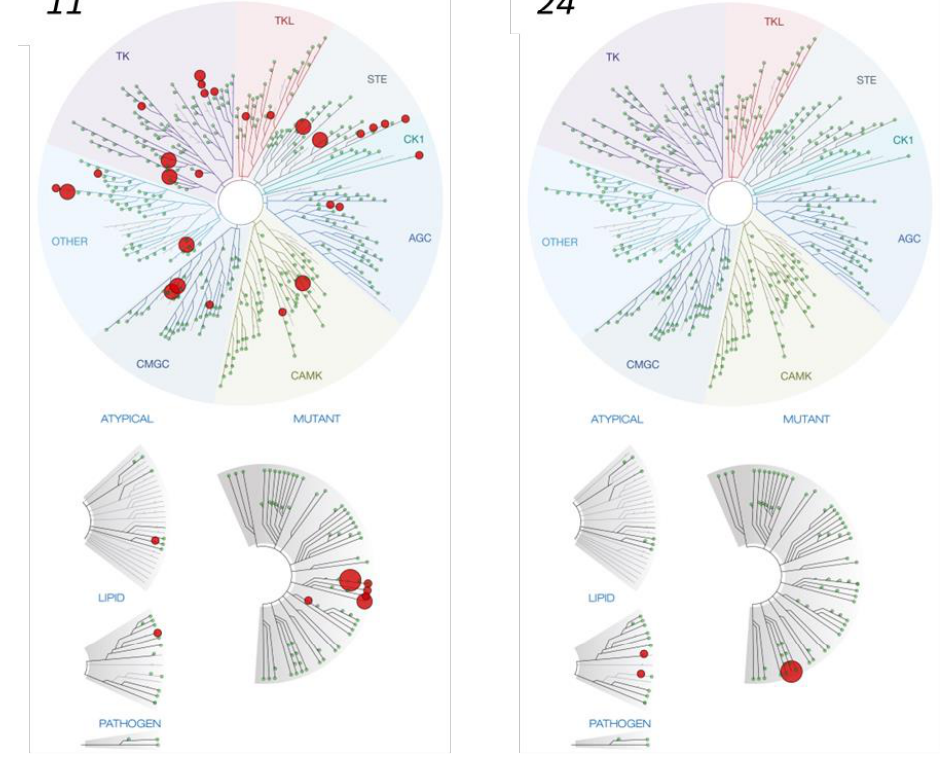
Figure 2. The TREEspot TM interaction map of 11 and 24 assayed at 1000 nM in the 468-kinase scanMAXSM panel. The panel includes 403 unique wild-type kinases and 59 mutant isoforms. Note that PERK is not included in the TREEspot assay but was evaluated in separate biochemical assays. Complete tabulated results presented in Supplemental Table S2.